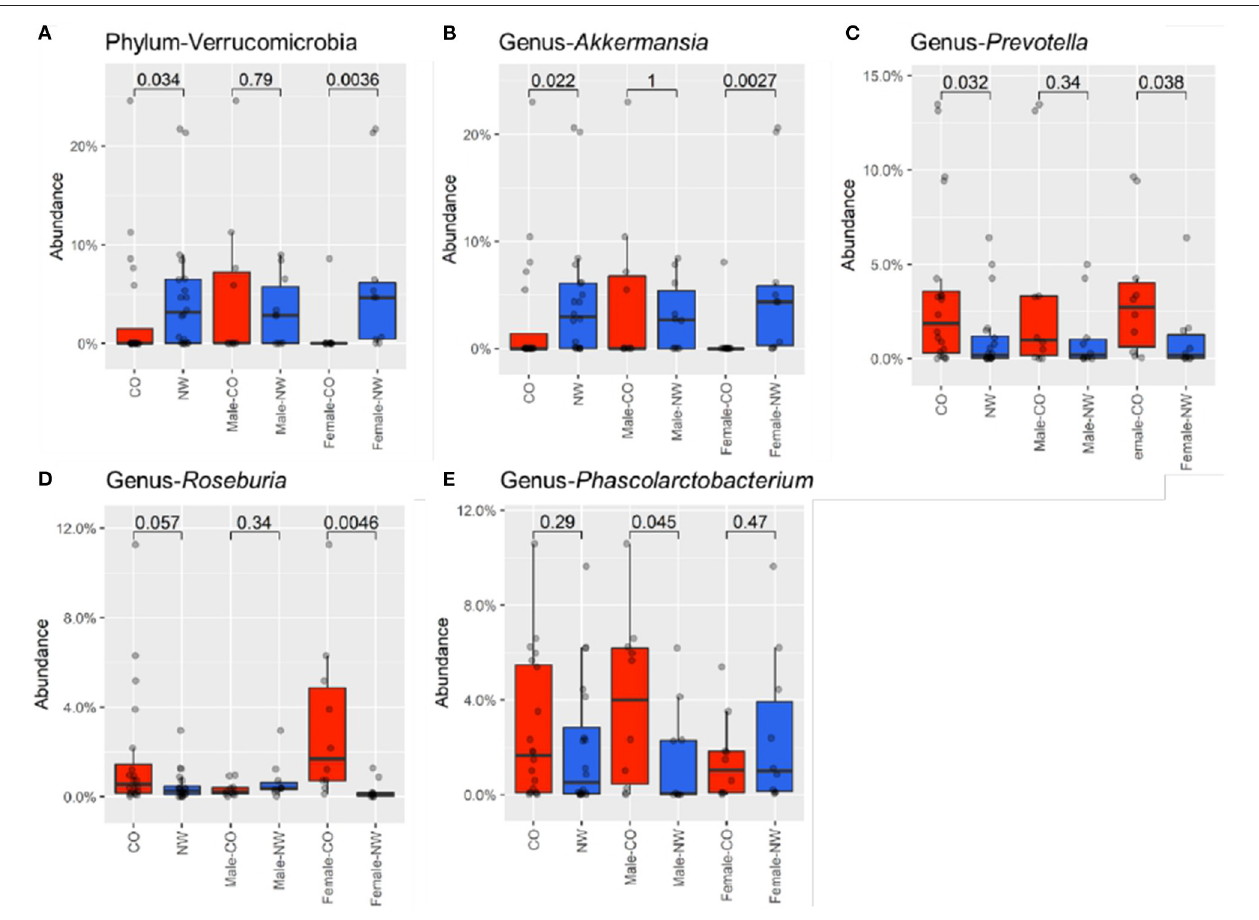
FIGURE 3 | Relative abundances were compared between male and female subjects with central obesity (CO) and normal weight (NW). The relative abundance of Verrucomicrobia at phylum (A) , genus of (B) Akkermansia , (C) Prevotella , (D) Roseburia , and (E) Phascolarctobacterium were compared. Female CO subjects had significantly lower abundance of Verrucomicrobia at the phylum level. At the genus level, relative abundance of Akkermansia was decreased in female CO subjects compared with female NW subjects, while Prevotella and Roseburia were increased in female CO subjects. Phascolarctobacterium was enriched in male CO subjects compared with male NW